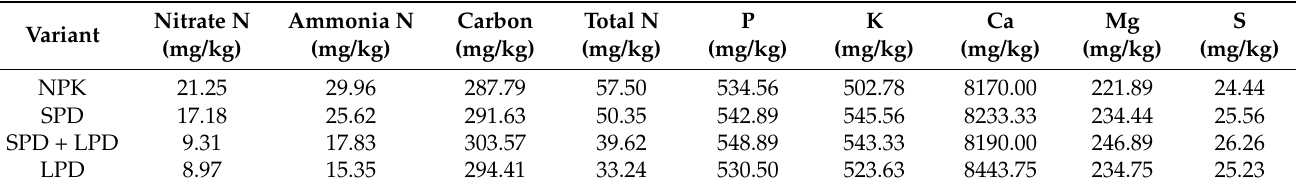
Table 6. Soils before